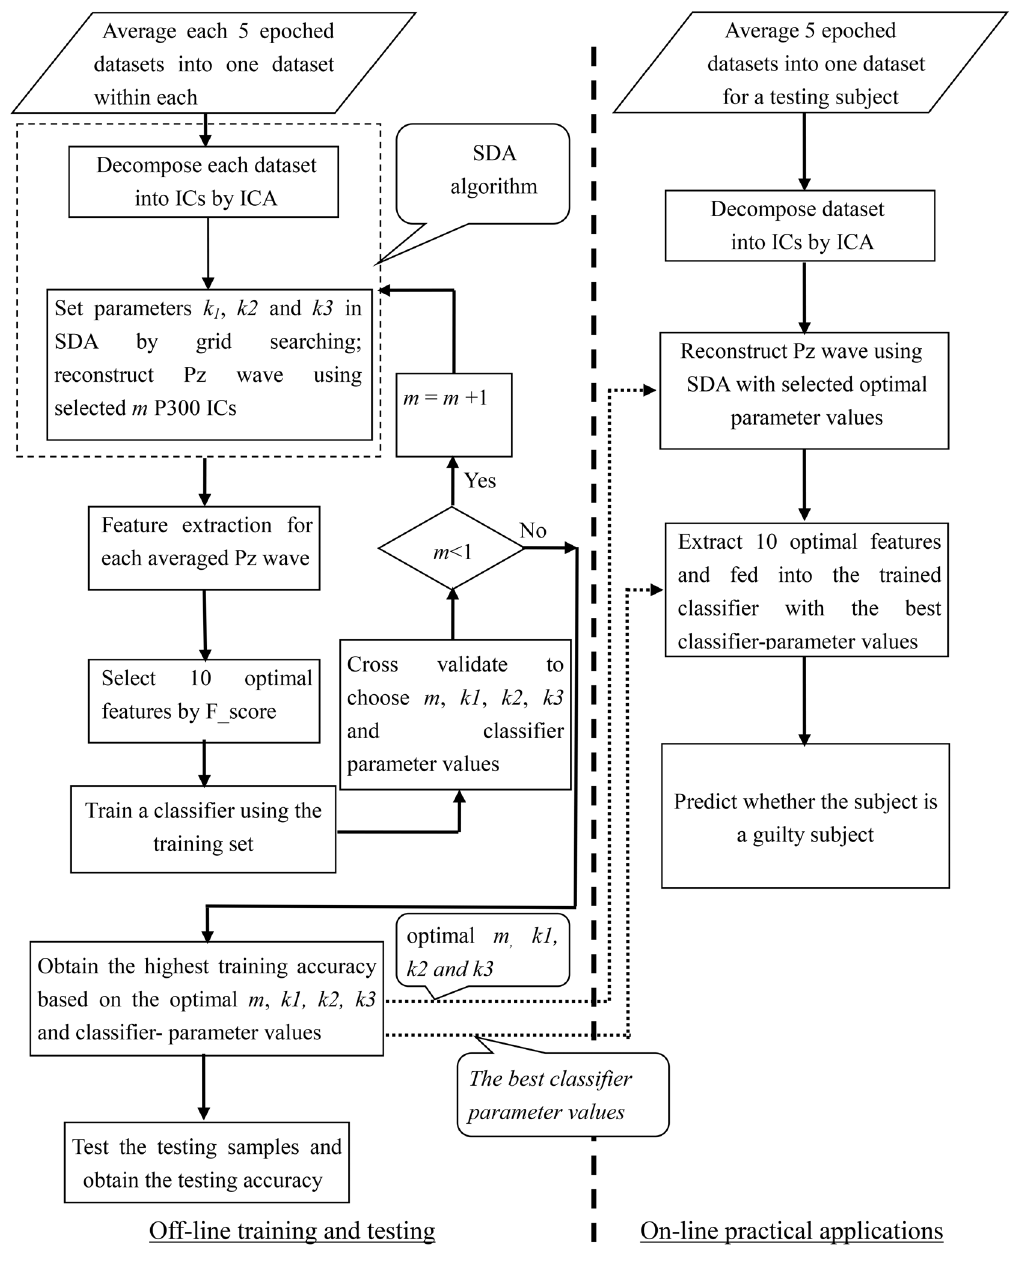
Figure 3. The flowchart of the presented CIT system.